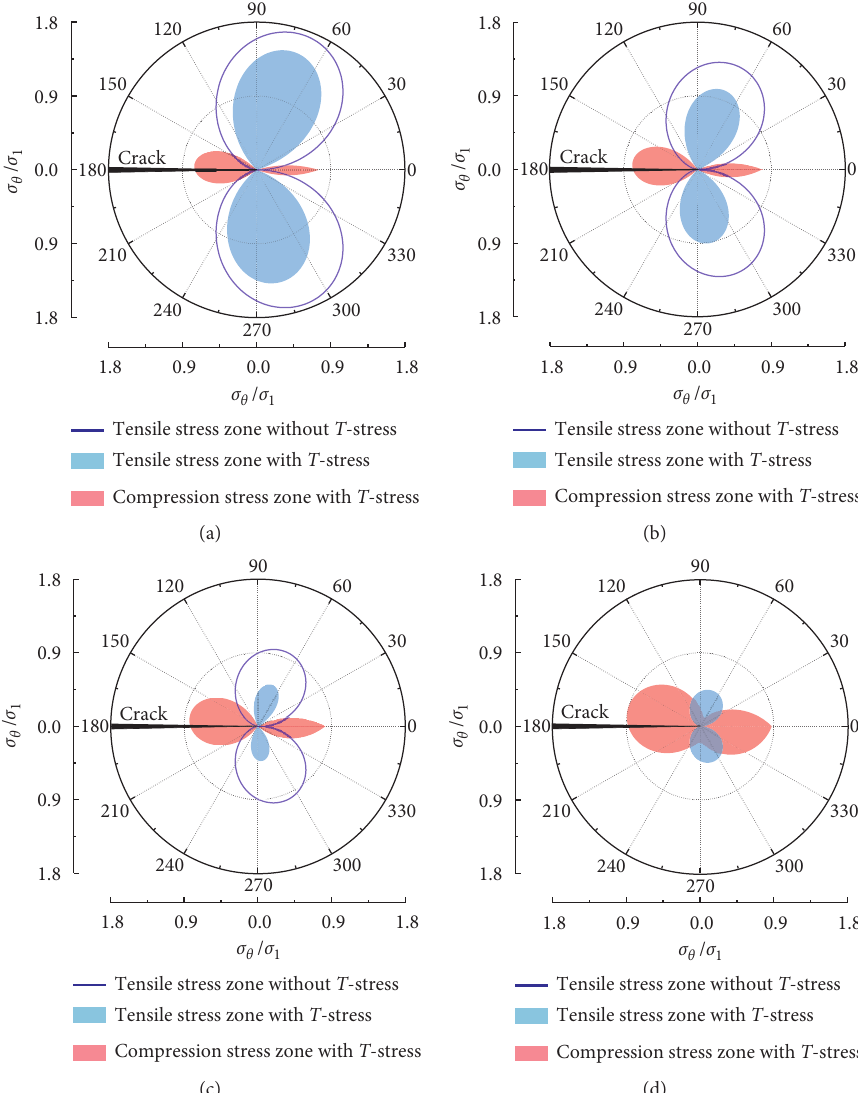
Figure 4: The ratio σ θ / σ 1 at crack tip under different confining pressure coefficients. (a) μ λ � 0.3. (d) μ � 0.15, λ �